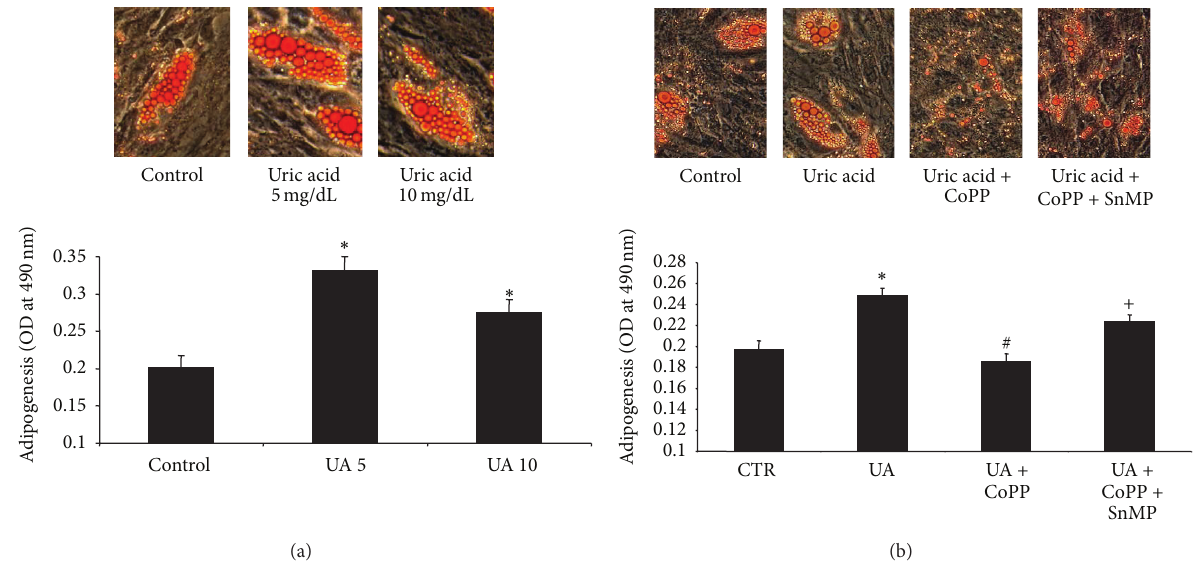
Figure 3: (a) Adipogenesis as shown by Oil Red O staining in MSCs treated with 5 mg/dL and 10mg/dL uric acid. A representative section for each group is shown. (b) Adipogenesis as shown by Oil Red O staining in MSCs treated with 5mg/dL uric acid with or without CoPP, in the presence or absence of SnMP, magnifications: 40x ( 𝑛 = 5 ). A representative section for each group is shown. Values represent means ± SEM of five independent treatments. ∗ 𝑝 < 0.05 versus CTR; # 𝑝 < 0.05 versus UA; and + 𝑝 < 0.05 versus UA +